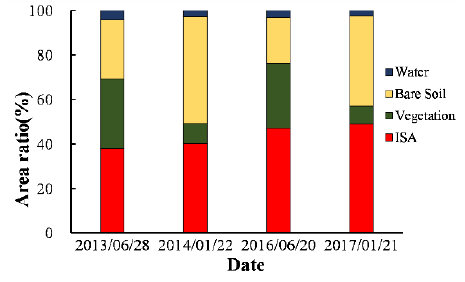
Figure 6. Land use / land cover changes in four Figure 6. Land use/land cover changes in four periods.